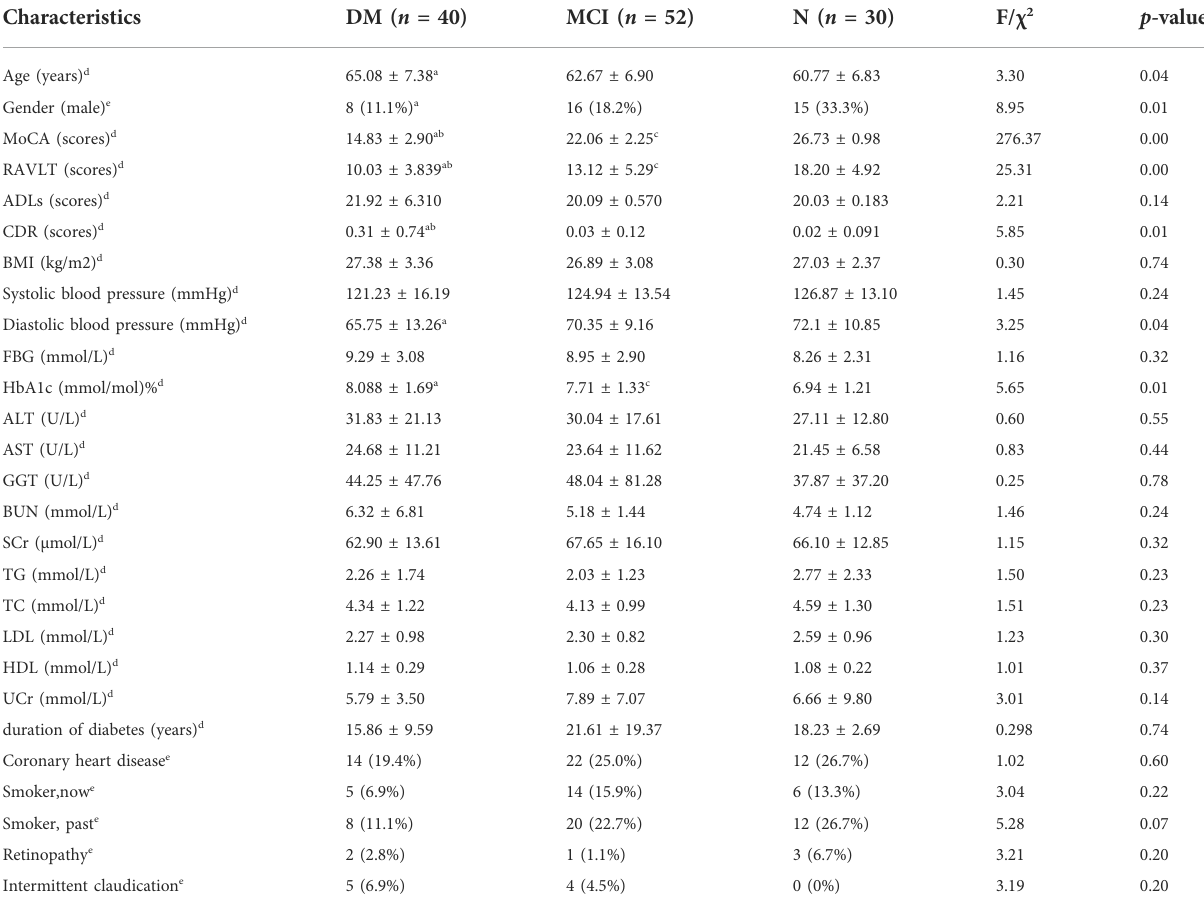
TABLE 1 Demographic and clinical characteristics of the MCI, DM, and N groups.